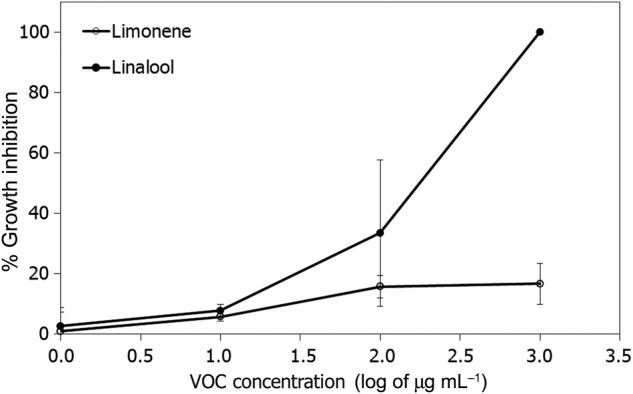
Inhibition of mycelial growth of C. acutatum at different concentrations of R-limonene and linalool. Dots represent the average of three experiments and three replicates for each rate.